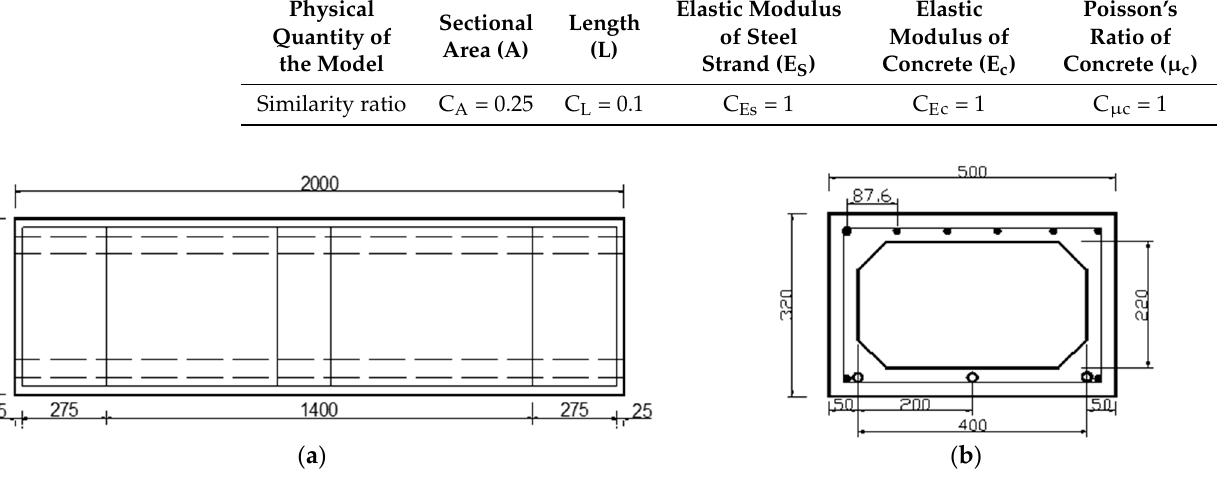
Figure 1. Longitudinal section, cross-section, and distributed steel of the prestressed hollow slab girder (mm): ( a ) Longitudinal section and; ( b ) Cross-section and distributed steel.